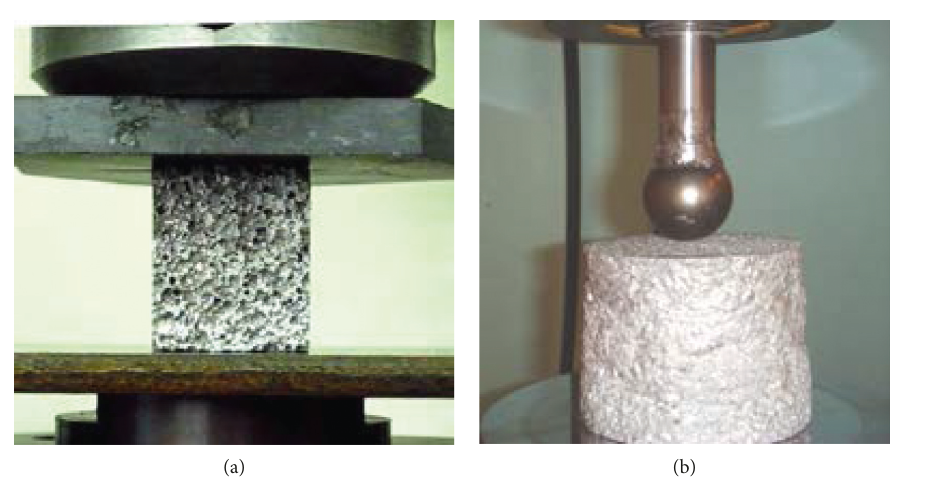
Figure 1: General view of the samples used in (a) compression and (b) indentation tests.